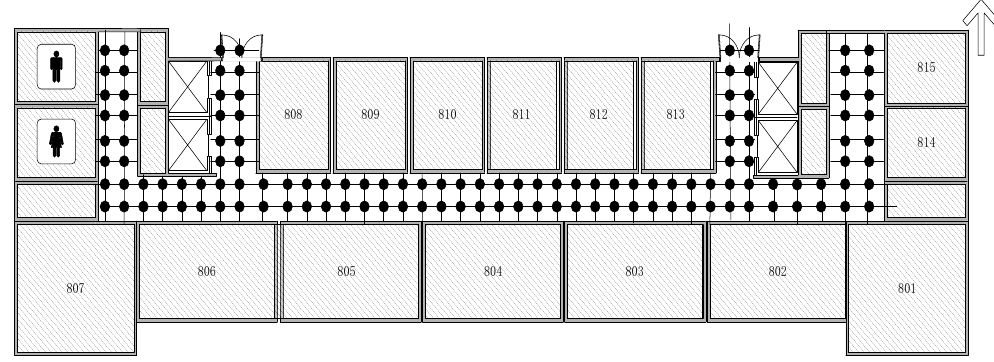
Figure 3. Floor plan of experiment area and anchor